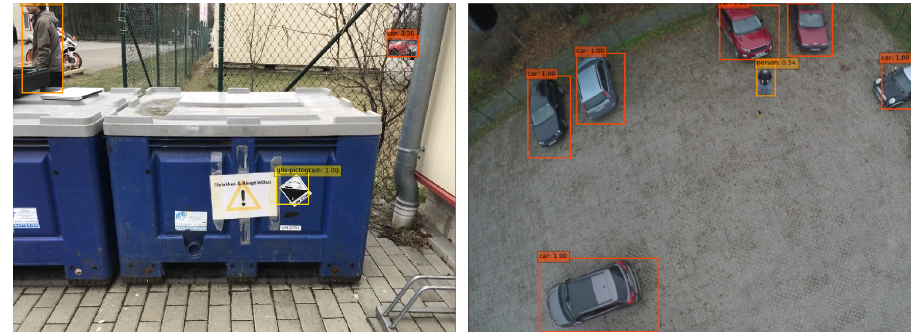
Figure 7. Object detection example: GHS (Globally Harmonized System of Classification, Labelling and Packaging of Chemicals) pictogram, person and vehicle. Number corresponds to confidence in